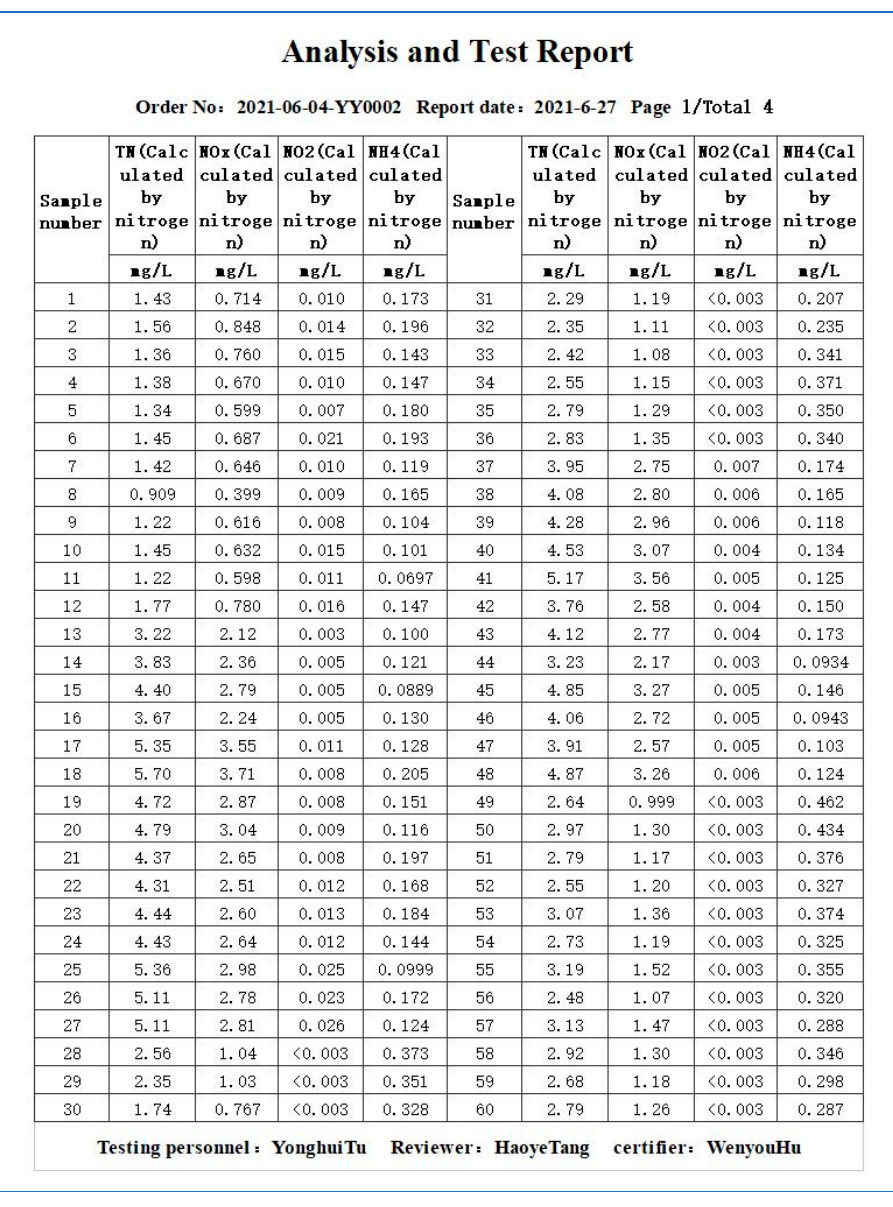
Figure 15. Standard data report format according to the specification requirements of the quality system.